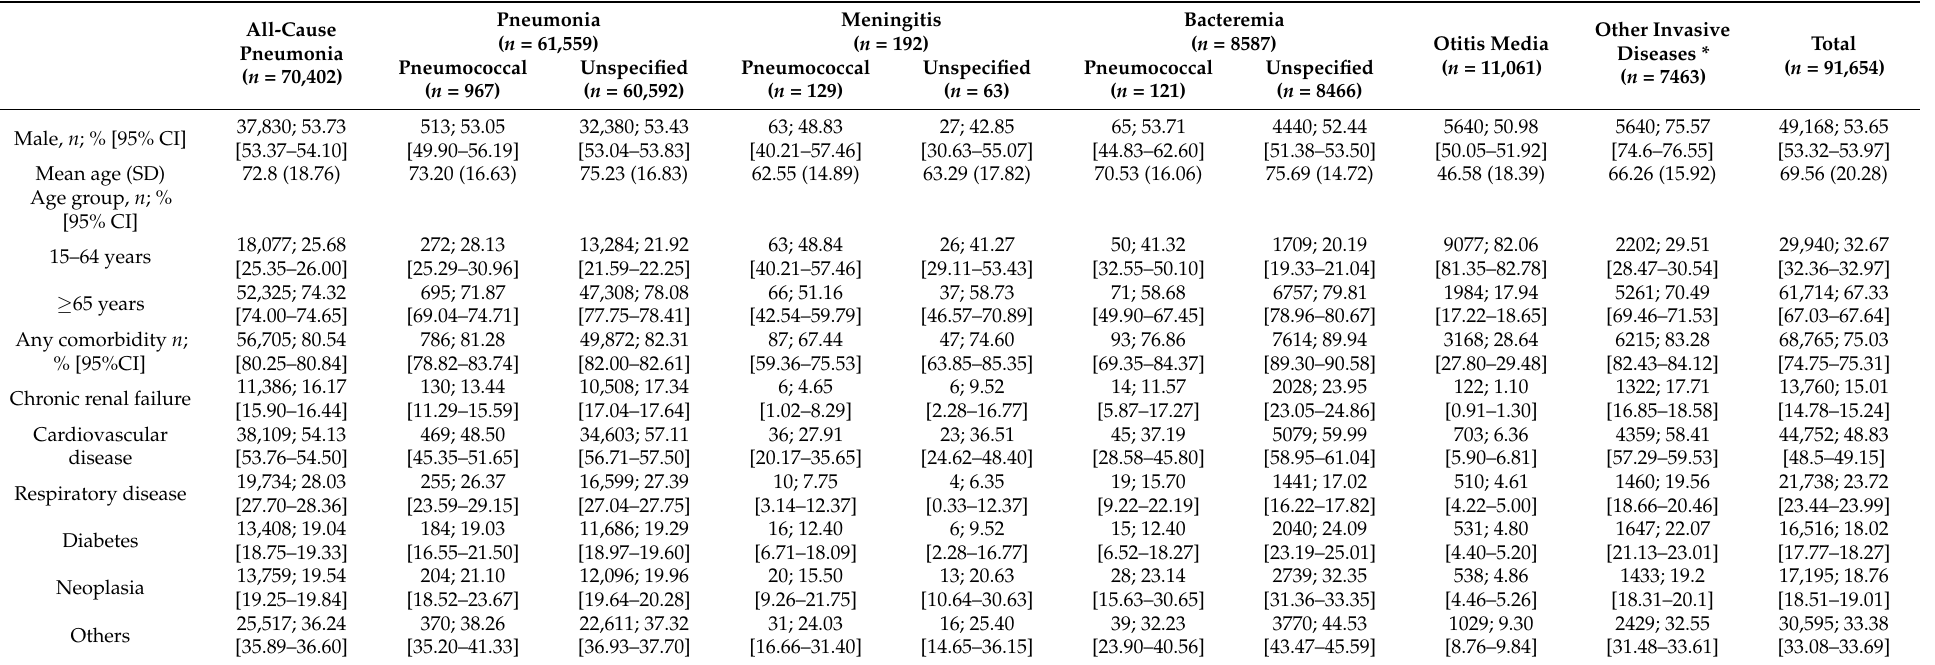
Table 1. Demographics of patient